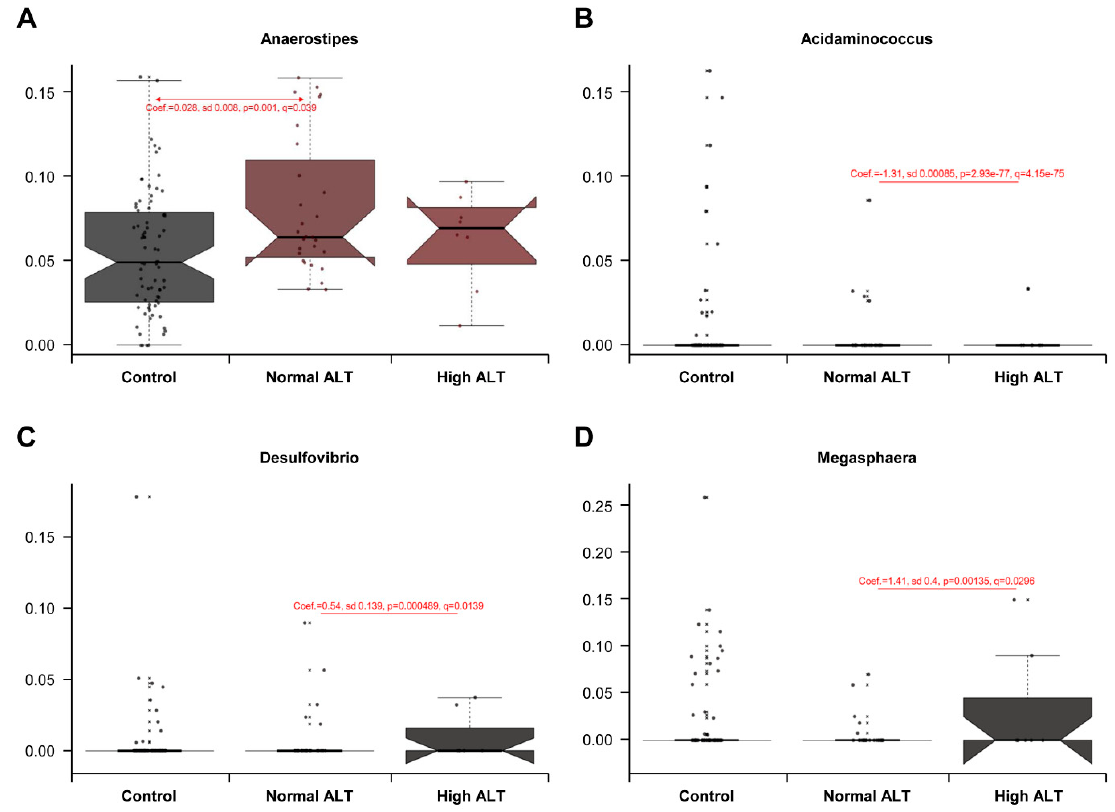
Figure 4. Significant associations between three groups and microbial taxa, Anaerostipes ( A ), Acidaminococcus ( B ), Desulfovibrio ( C ), and Megasphaera ( D ). The coefficient ( Coef. ) and q value were shown in each plot. The values of q were determined with MaAsLin analysis.